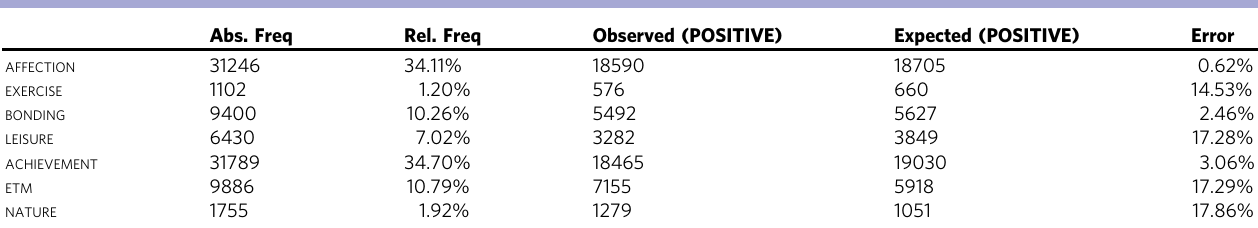
Fig. 2 Polarity distribution for Transformers (left) and Lingmotif (right). The distribution of polarity shows the percentage of messages that are classi fi ed as positive, negative, or neutral. Table 2 Happy moments ( n = 91608) classi fi ed as positive by Lingmotif (by